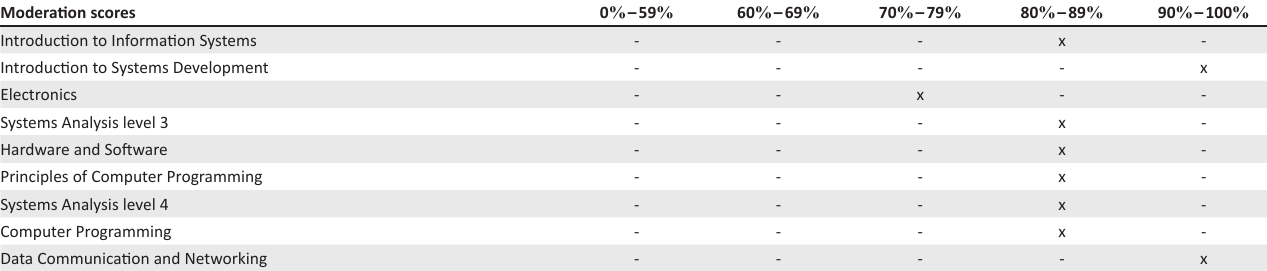
TABLE 3: The moderation scores after the knowledge portal